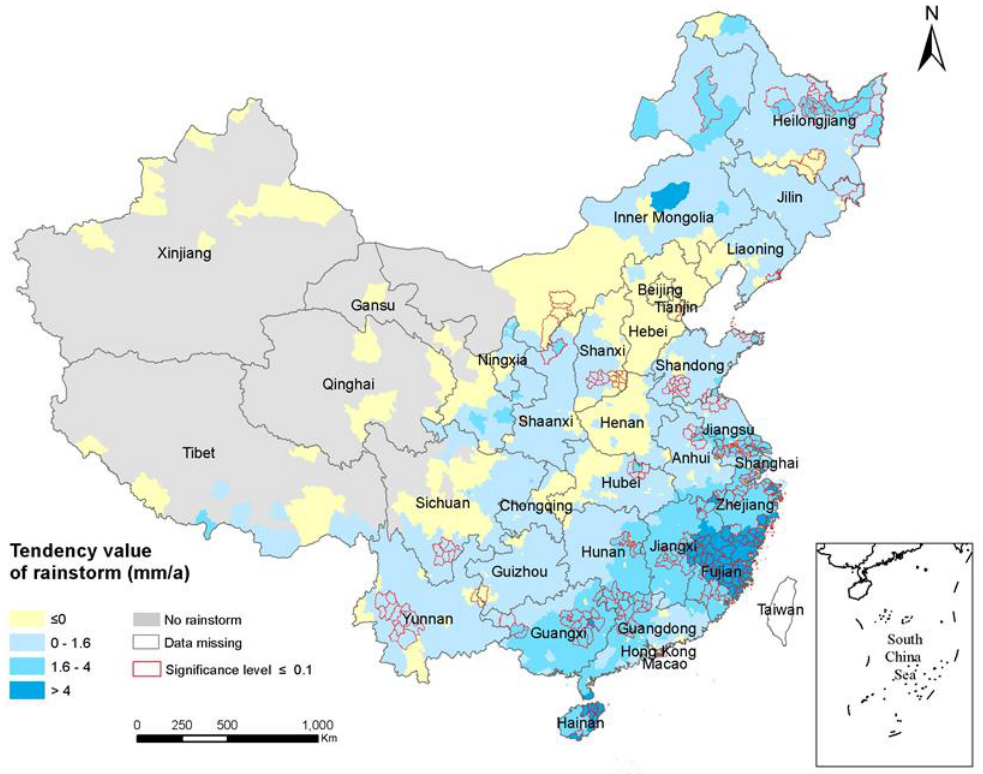
Figure 2. Trend of annual rainstorms from 1975 to 2015.